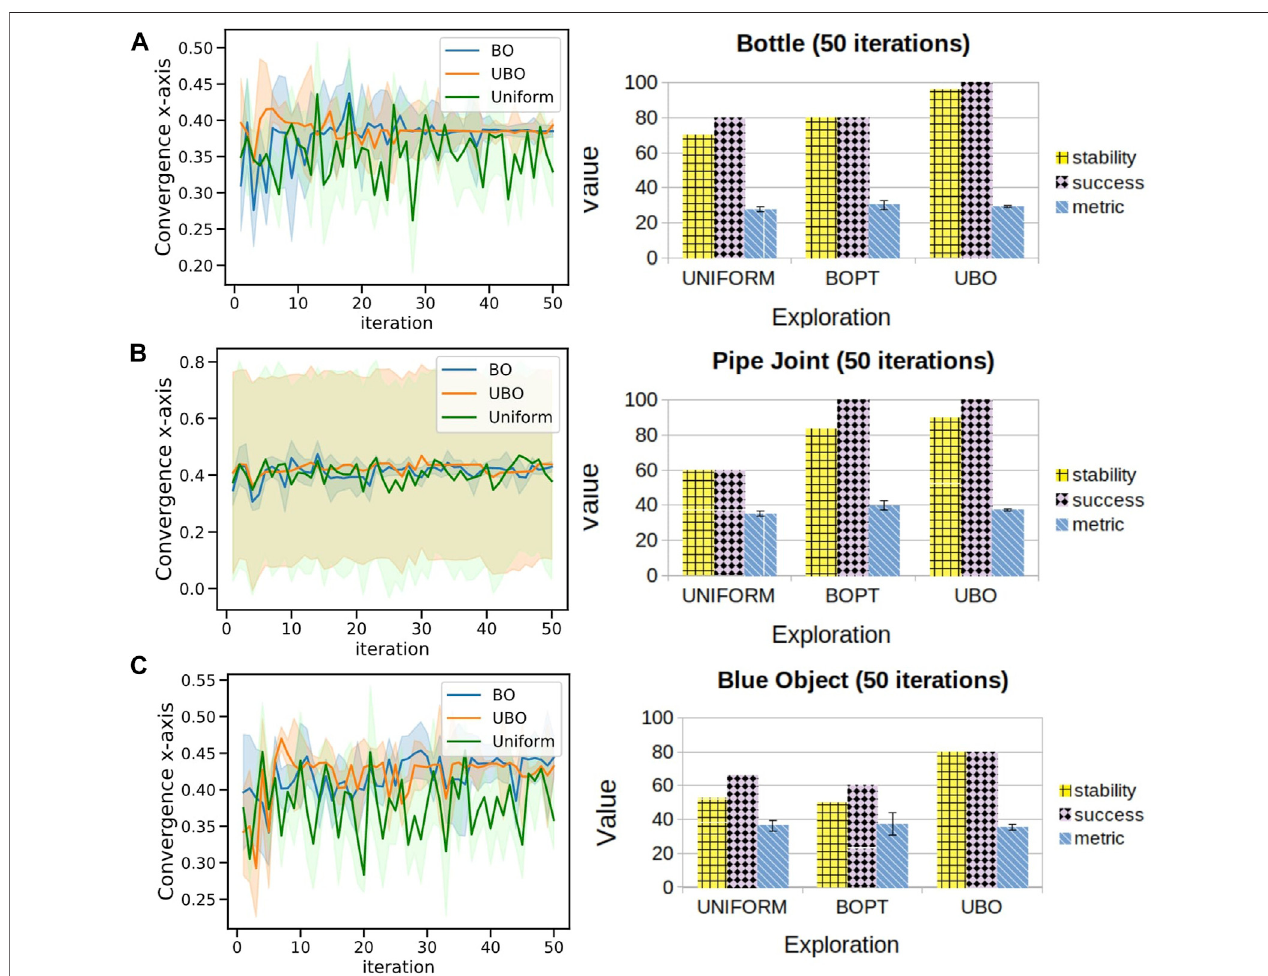
FIGURE5| Leftcolumndisplaysperformanceofuniform,BOandUBOexplorationsinconvergingto fi naloptimum position( x -axis)inallexperimentsfor (A) bottle, (B) pipe joint and (C) blue object. Right column shows stability scores and mean of the highest grasp metric for different exploration methods.